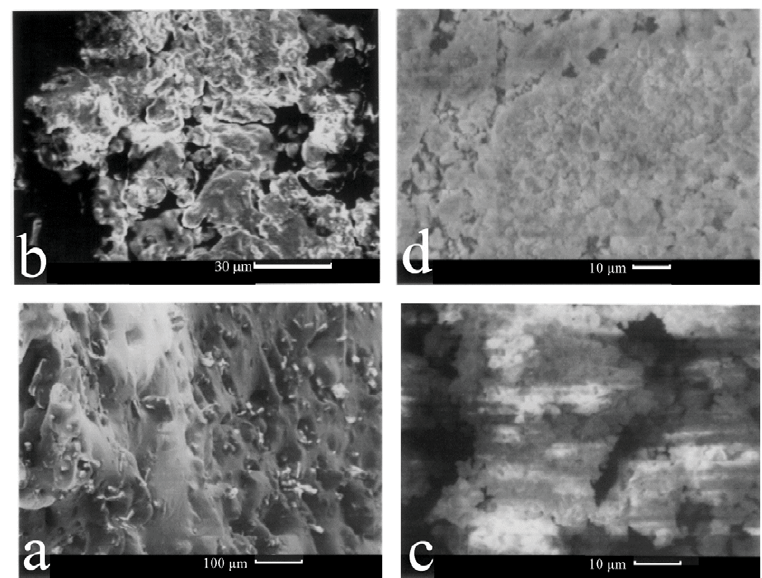
Figure 13. Scanning electron micrographs of (a) La-Co-O, (b) La(0.75)-Sr(0.25)-Co-O, (c) La(0.5)-Sr(0.5)-Co-O, and (d) La(0.25)-Sr(0.75)-Co-O precursor gels.